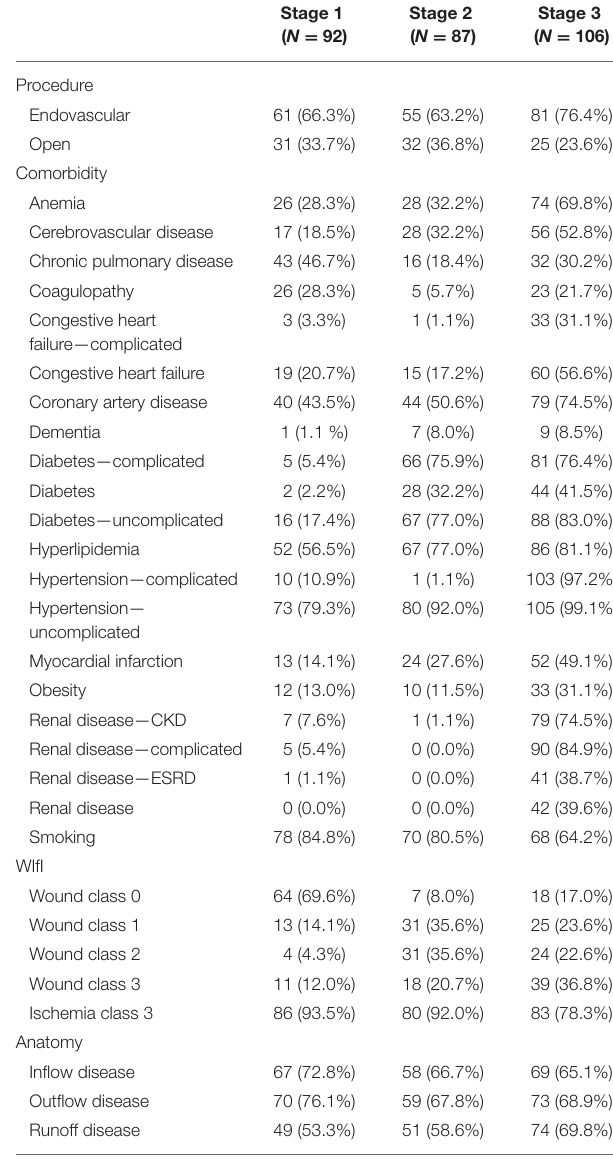
TABLE 1 | Demographic and comorbidities of overall population. TABLE 2 | Characteristics of CLTI patients belonging to each